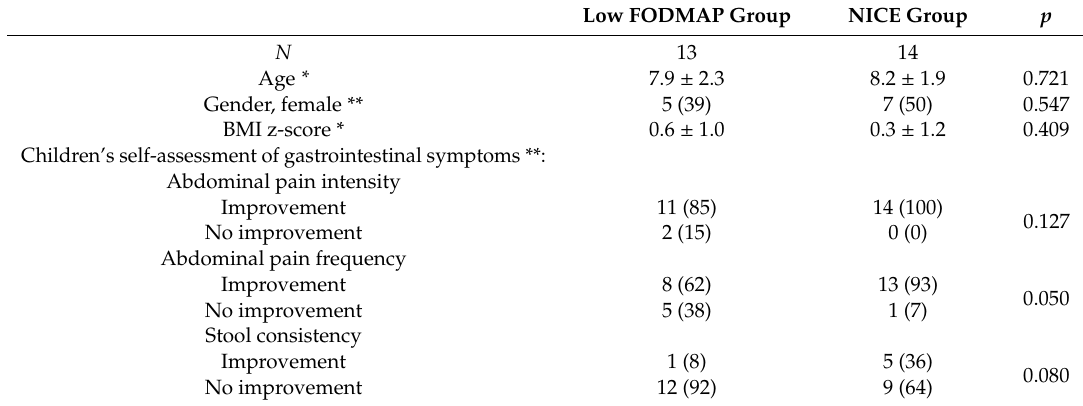
Table 1. Baseline characteristics of patients with functional abdominal pain.